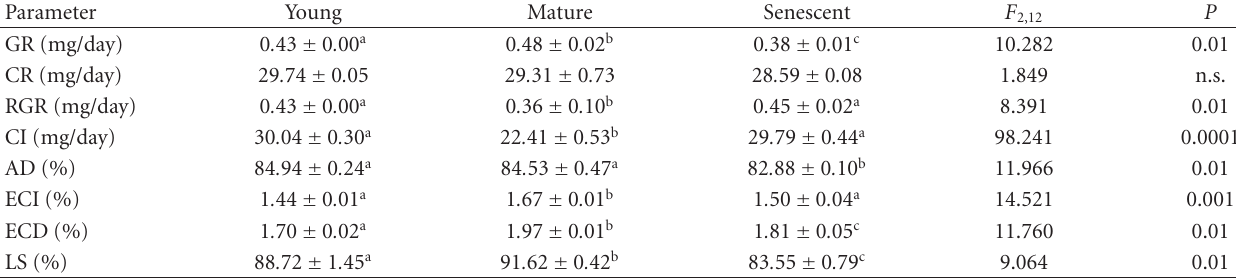
Table 3: Food utilization e ffi ciency measures of second instar larva of D. casignetum reared on young, mature, and senescent sunflower